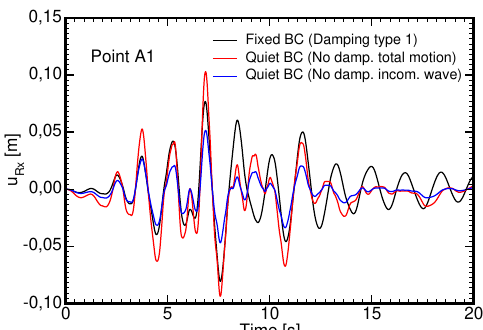
Figure 10. Comparison of damped model with FBB and undamped model with QBB .